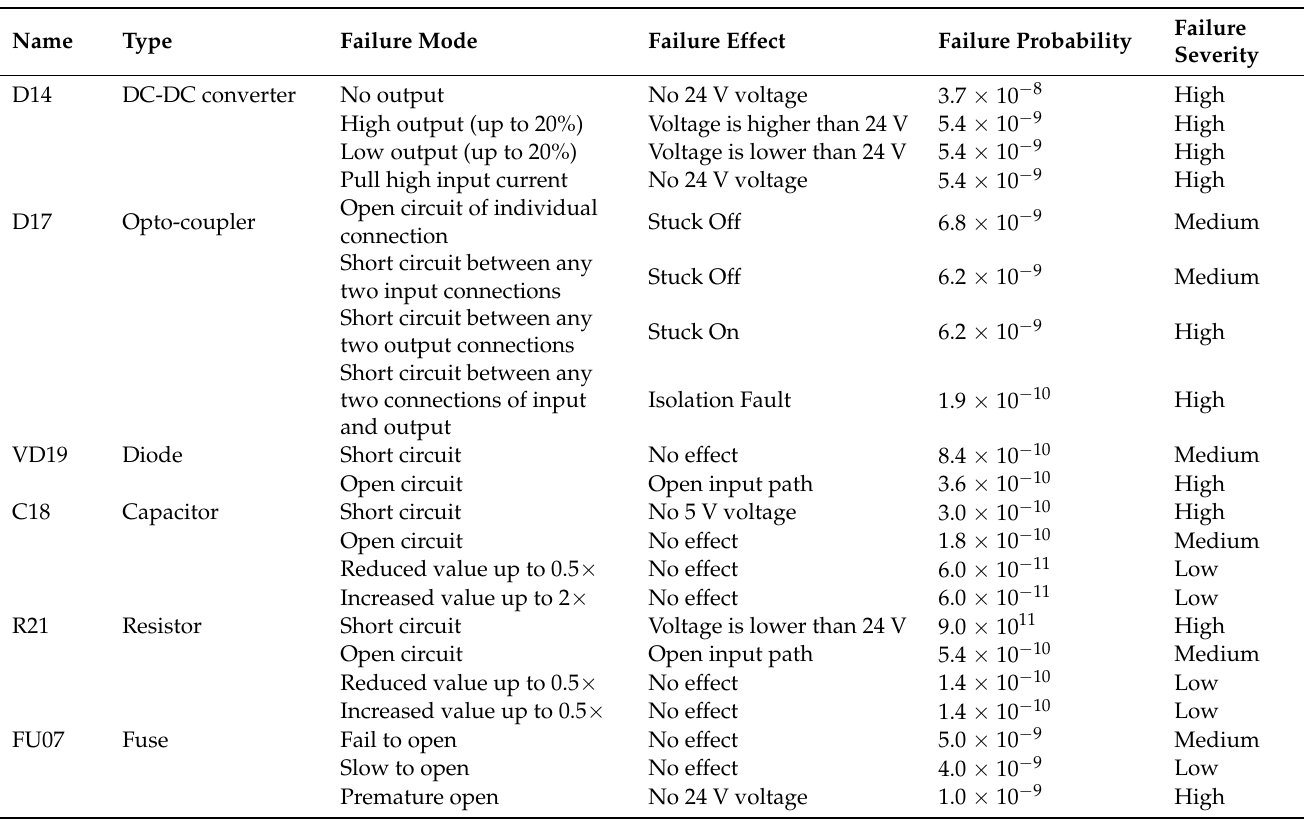
Table 9. FMECA table after ScC application.